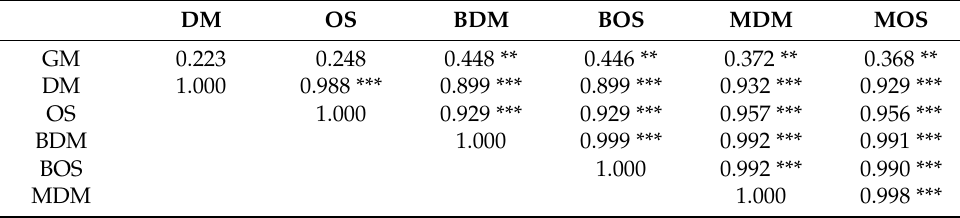
Table 8. Coefficients of the correlation with the dependent variables. Note: GM: the green mass yield; DM: dry matter yield; OS: yield of organic solids; BDM: biogas yield from dry matter; BOS: biogas yield form organic solids; MDM: methane yield from dry matter; MOS: methane yield from organic solids. Significance of the correlation were at of **: p < 0.001; ***: p < 0.0001. DM OS BDM BOS MDM